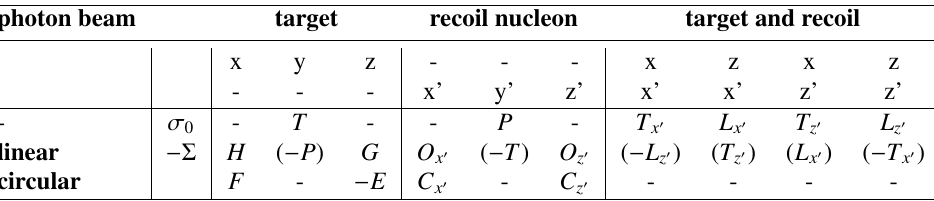
Table 1. Table lists all possible polarization observables that can be obtained by using a polarized photon beam, a polarized target by measuring the recoil nucleon polarization degree. Some observables can be measured in two di ff erent ways, e.g. P can be measured as a single polarization observable or as a double polarization observable with linearly polarized photon beam and a transversely polarized target. All information are taken from